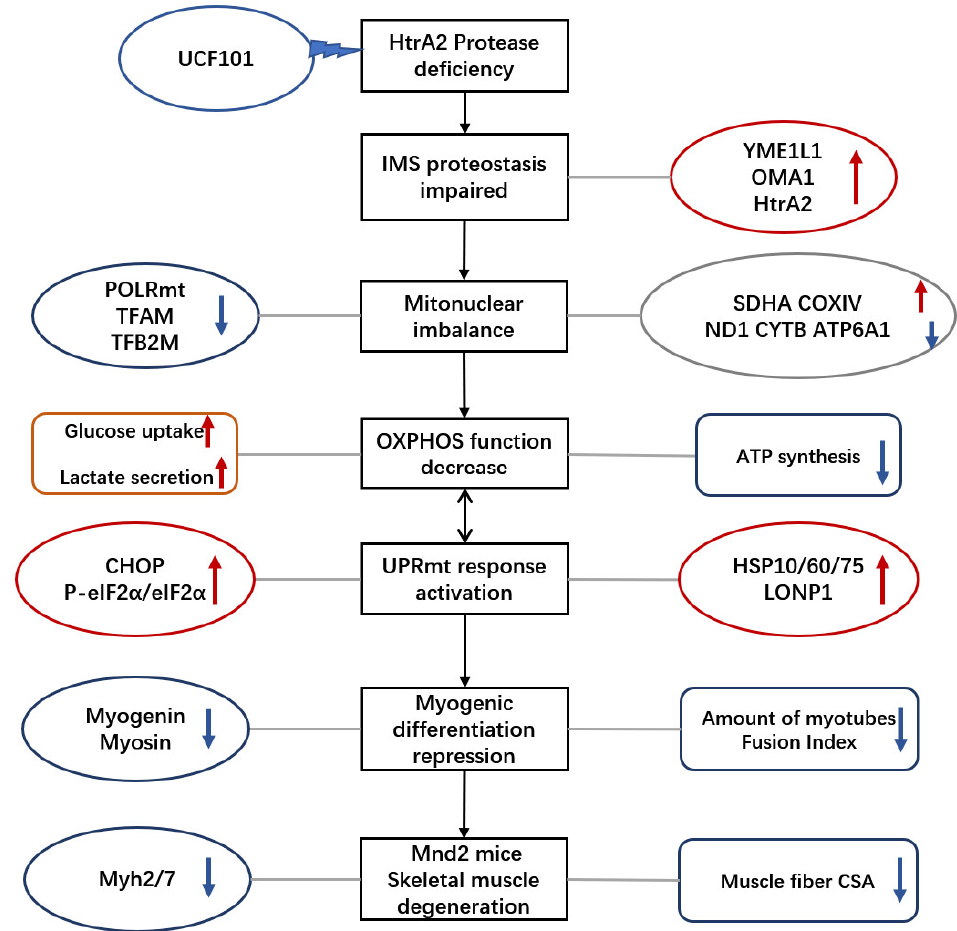
Figure 8. Mode picture. The arrows and circular marked in red: these indicators were upregulated The arrows and circular marked in blue : these indicators were downregulated.